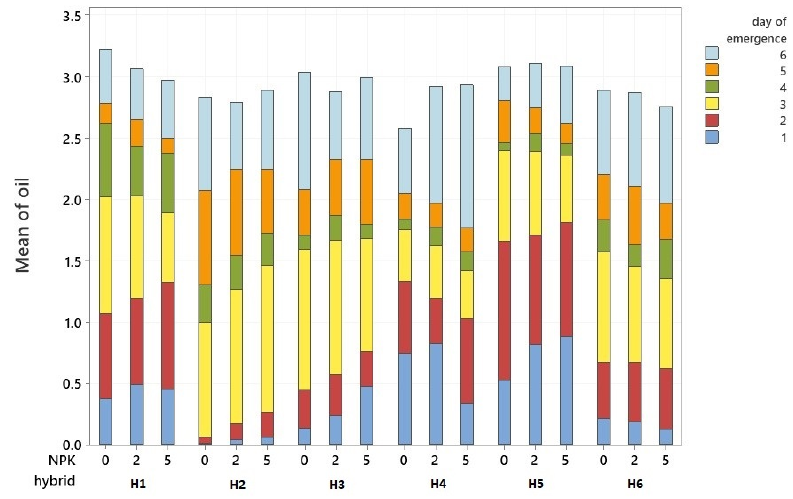
Figure 4. Interaction between hybrids, fertilizer, and day of emergence on oil content.